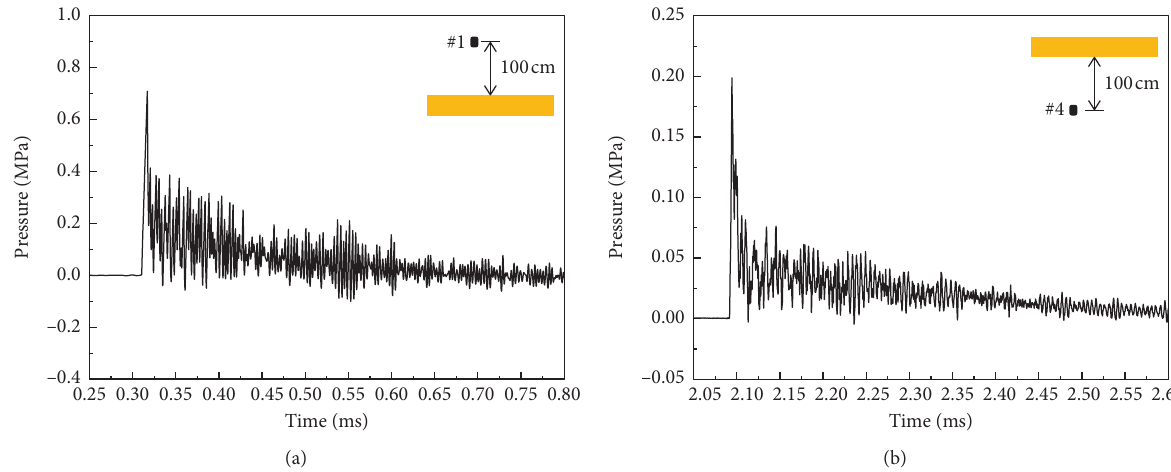
Figure 18: Time history curves of shock wave pressure in slab B4. Air shock wave measured using (a) sensor #1 and (b) sensor #4.